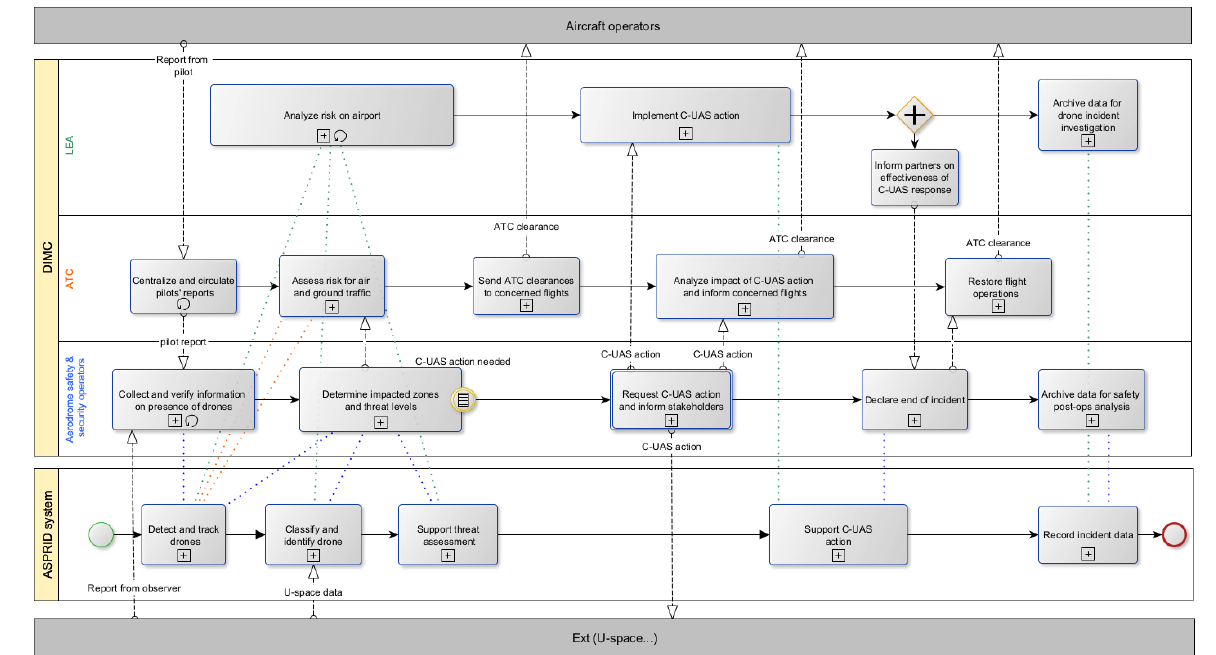
Figure 1. BPMN process diagram of the tactical phase of ASPRID process model.